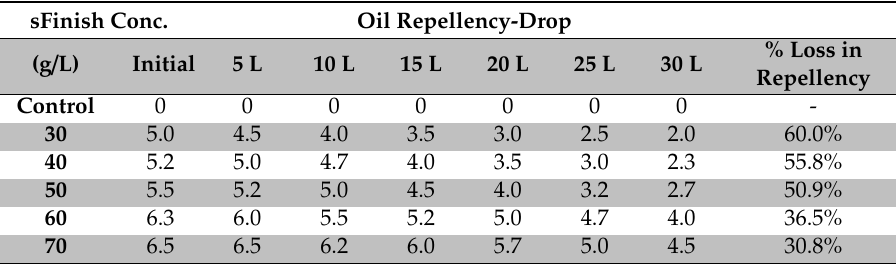
Table 3. E ff ect of laundering on oil-repellency (drop test) of polyester / cotton. Table 3. Effect of laundering on oil-repellency (drop test) of polyester/cotton. sFinish Conc. sFinish Conc.